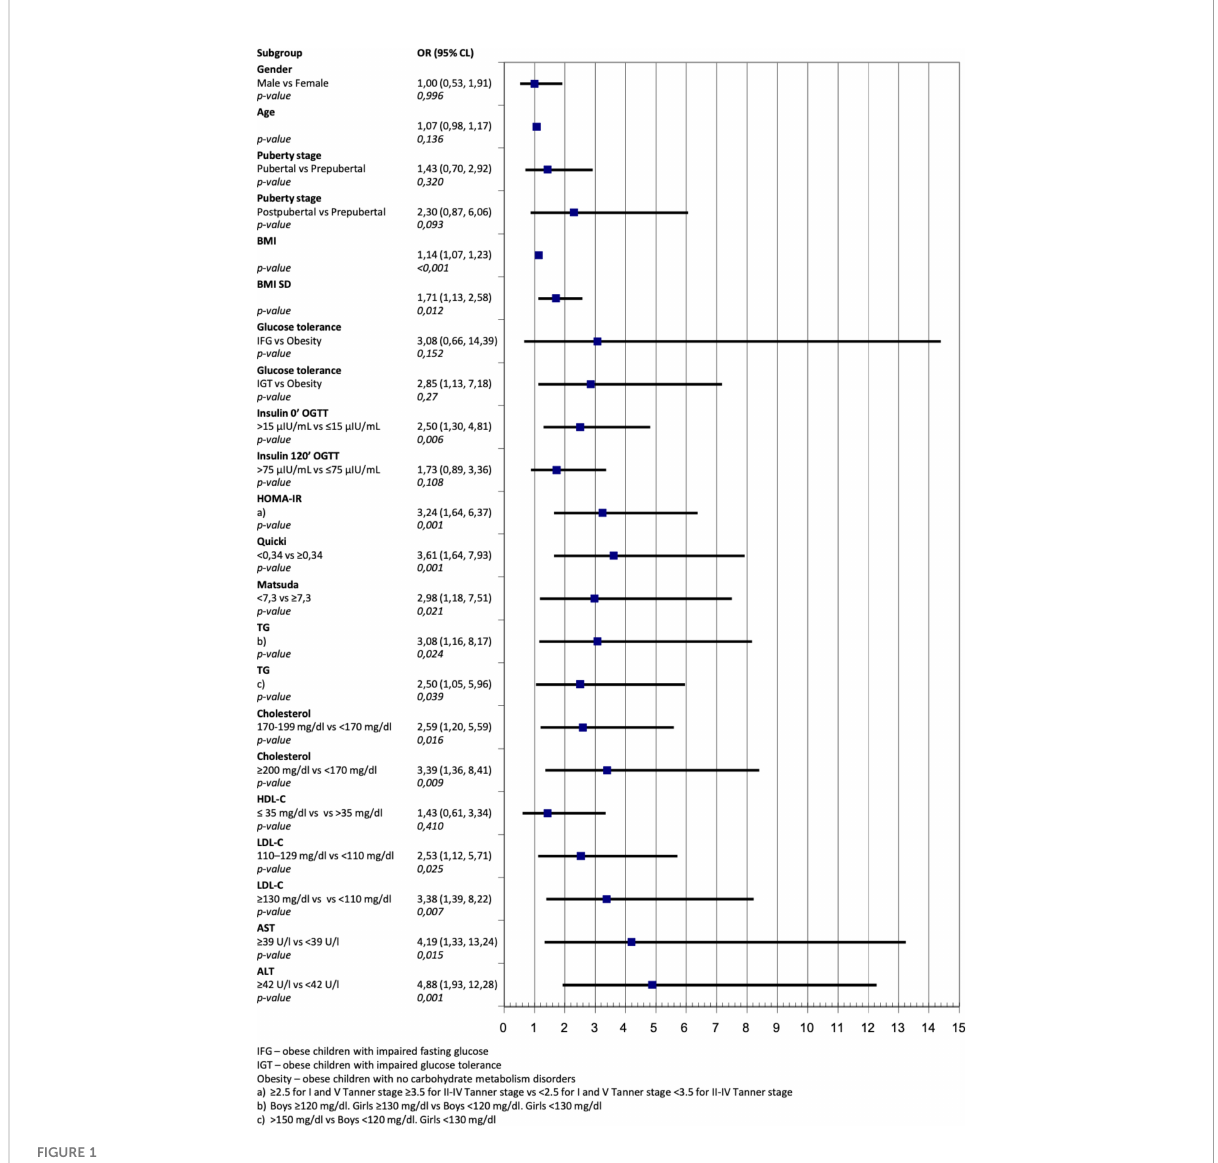
FIGURE 1 Odds ratio for fatty liver on ultrasound for different anthropometrics and biochemical